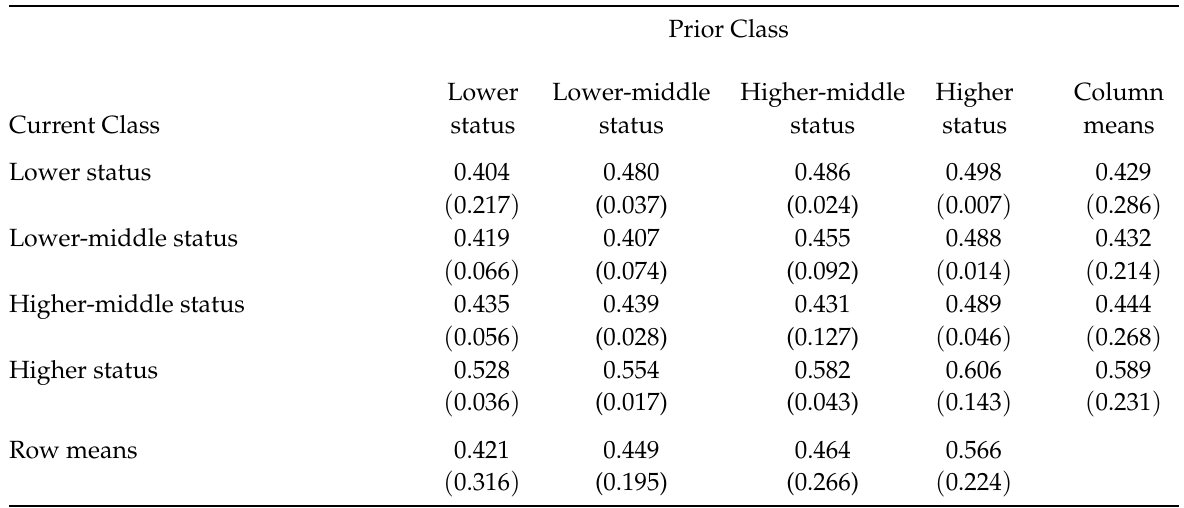
Numbers in parentheses indicate mean proportions of respondents in each cell of the mobility table.